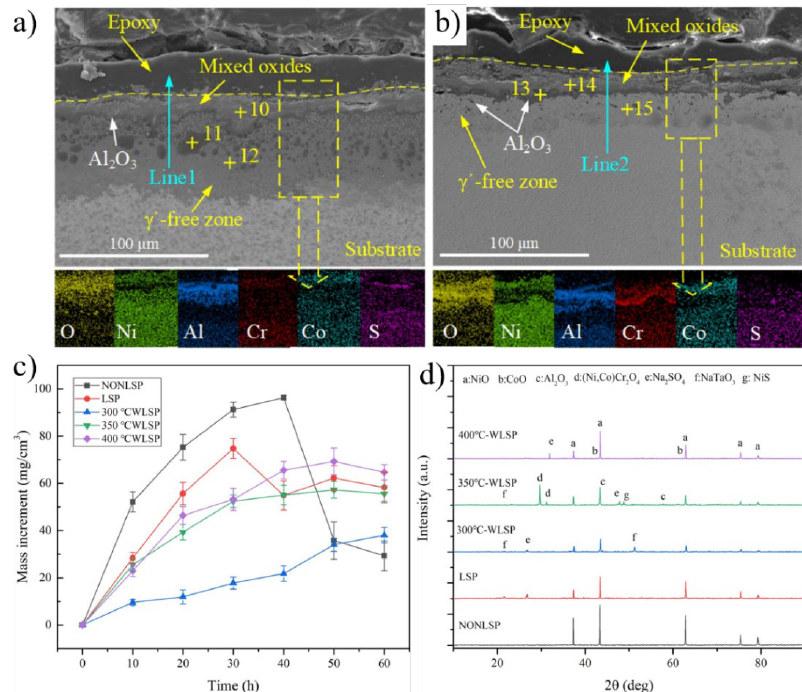
Figure 7. Cross sectional SEM image of ( a ) untreated and ( b ) LPed Ni-based superalloy following hot corrosion tests with corresponding EDS maps. Mass increment vs. time plot for untreated, LP, and WLSP treated material at different stages of a hot corrosion test ( c ) as well as corresponding XRD patterns showing the presence of various oxides and salts ( d ). Reprinted from [52,53] with permission from Elsevier.